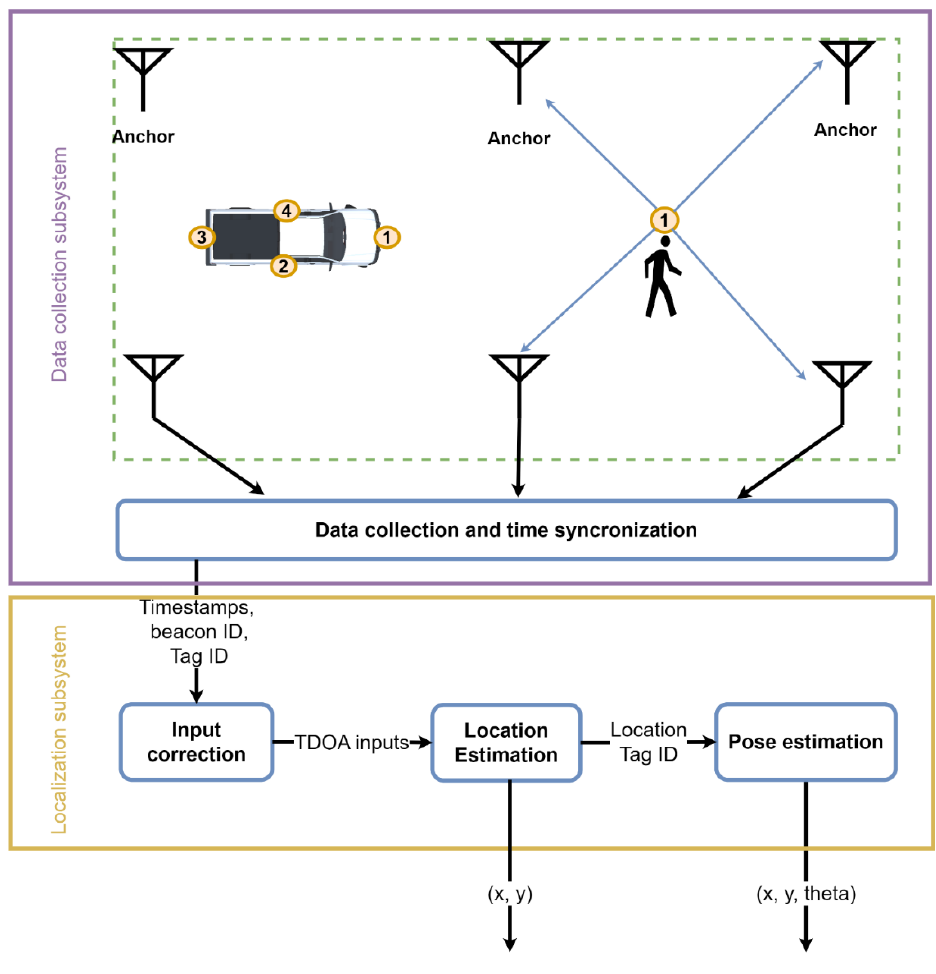
Figure 1. Overview of